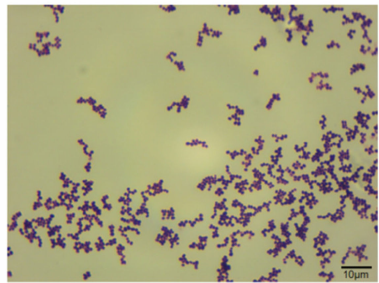
Figure 2. Gram staining of the isolated bacterium (1000 × magnification).